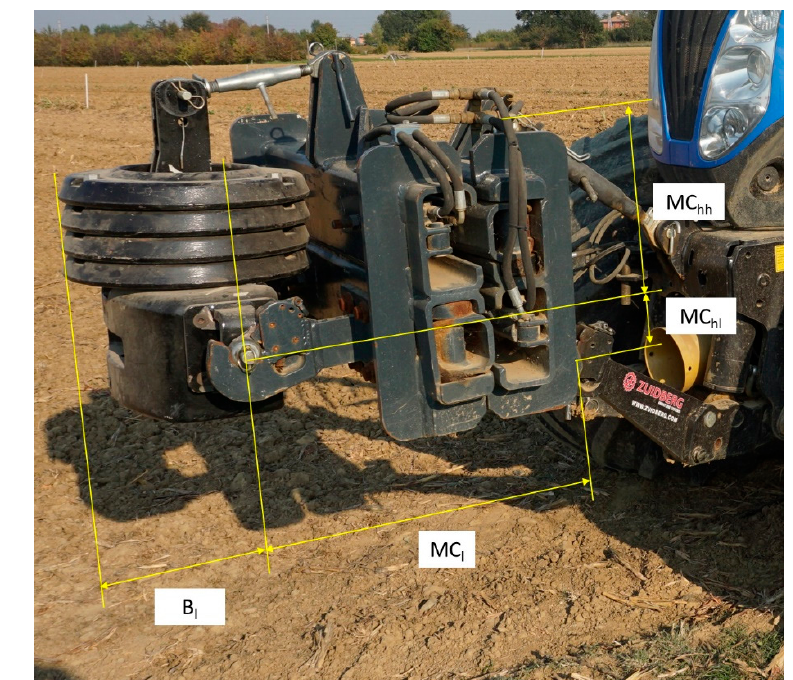
Figure A3. Multiplier Counterweight and ballast dimensions.